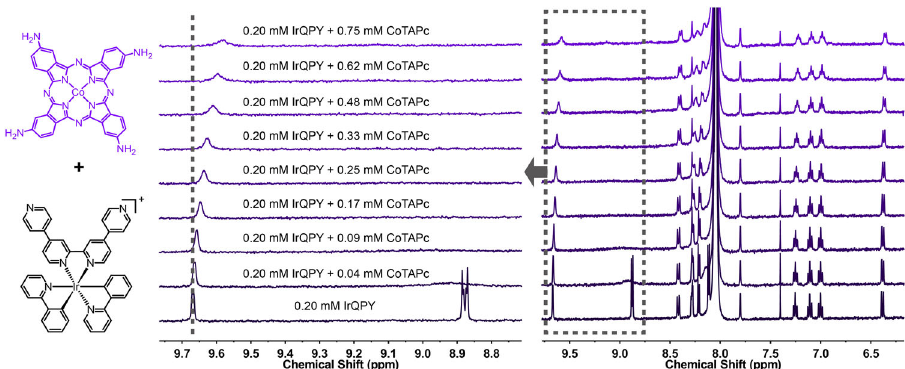
Fig. 4 1 H NMR titration. 1 H NMR titration with CoTAPc into a 0.20 mM DMF-d 7 solution of IrQPY, highlighting some shifted pendent pyridyl proton